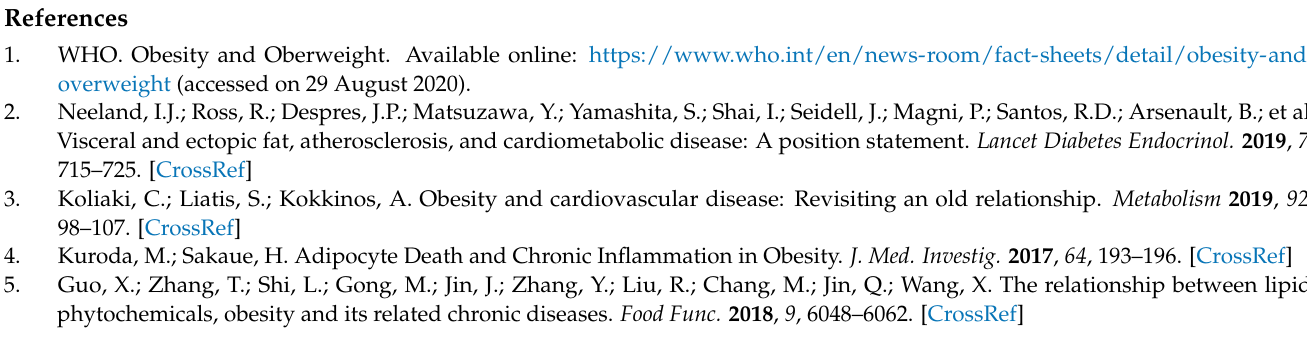
Figure A1. Publication bias.